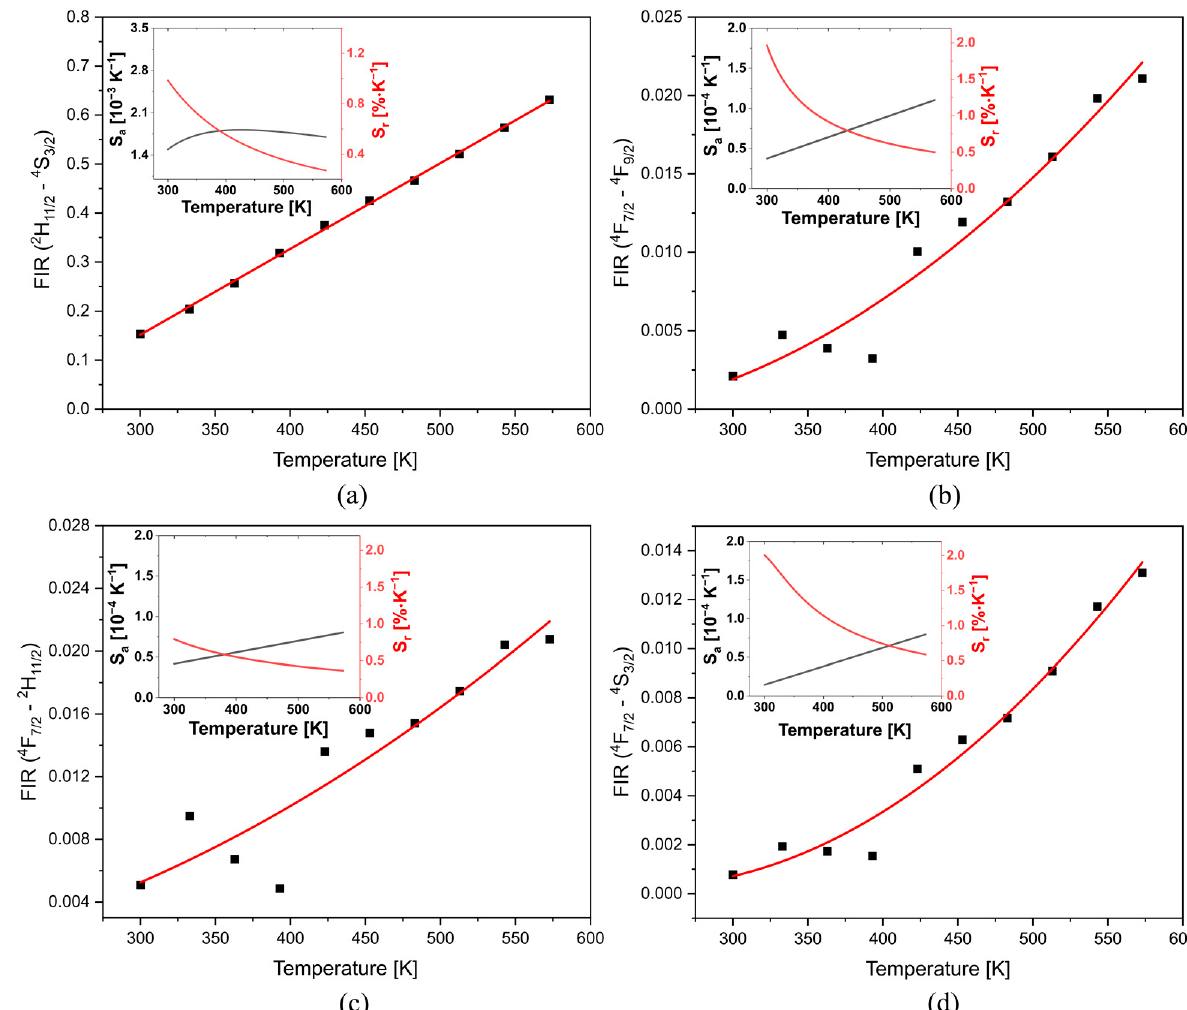
Figure 6. The glass fiber FIR of ( a ) TCLs ( 2 H 11/2 — 4 S 3/2 ); ( b ) non ‐ TCLs ( 4 F 7/2 — 7 F 9/2 ); ( c ) non ‐ TCL—TCL ( 4 F 7/2—2 H 11/2 ); ( d ) non ‐ TCL—TCL ( 4 F 7/2 — 4 S 3/2 ). Insets show the absolute and relative sensitivity.